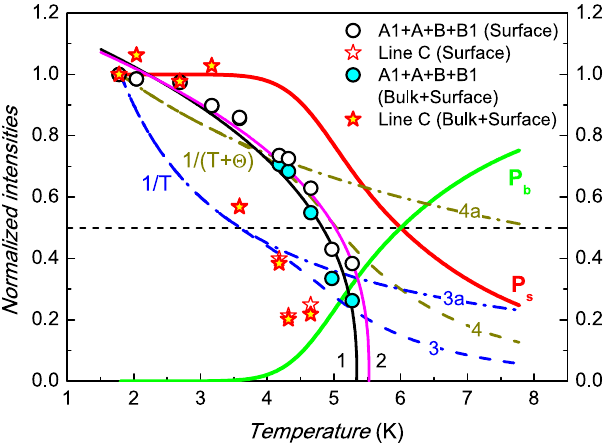
Figure 3. The comparison of the possible effects of MW radiation absorption at the SmB 6 surface and in the sample bulk. Open symbols correspond to raw integrated intensities normalized to the value at T = 1.8 K; symbols filled by colors denote the recalculated values assuming dominating surface contribution. Curves 1, 2 are the best fits obtained with the help of Equation (1); curves 3, 4 are the temperature dependences expected for Curie and Curie-Weiss spin susceptibilities assuming dominating surface contribution. Curves 3a and 4a are the same as curves 3 and 4 for the case when paramagnetic centers are uniformly distributed in the sample (see text for